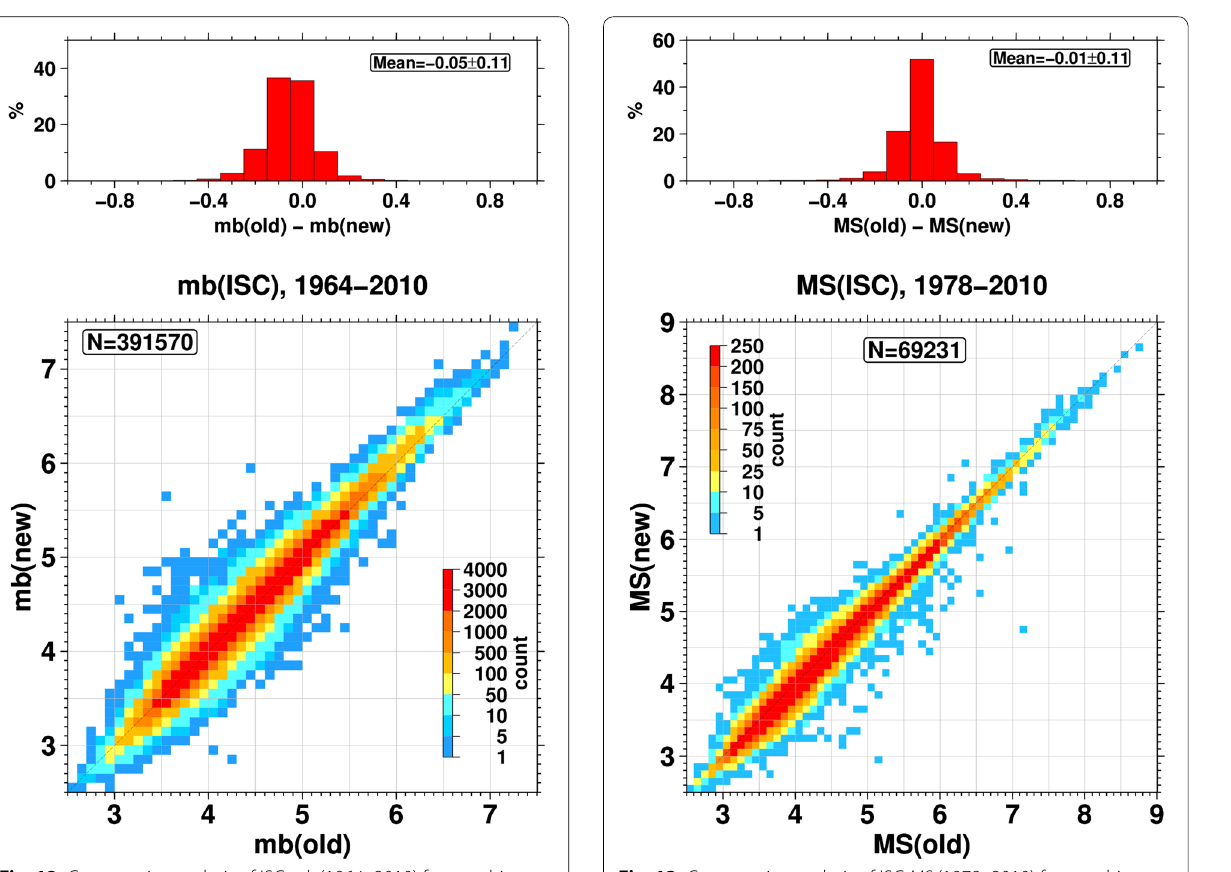
Fig. 13 Comparative analysis of ISC MS (1978–2010) for matching 69,231 events in the original and rebuilt ISC Bulletins